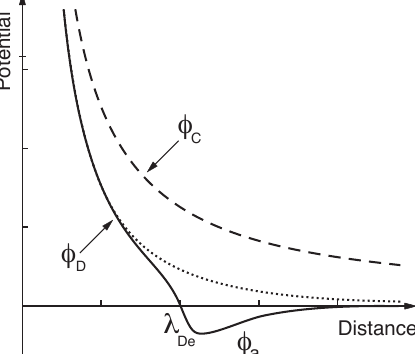
Figure 1. Schematic comparison between the dc Coulomb ( 8 C ), Debye ( 8 D ) and plasma wave modified ( 8 a ) potentials for the case when the modified potential evolves an attractive domain. In all cases considered the potential is repulsive inside the Debye sphere at distances ≤ λ De . In the presence of (electrostatic) plasma waves investigated in this paper the dc potential 8 a outside but close to a distance λ De develops a region where it becomes negative. At large distances the effect of the plasma wave decreases